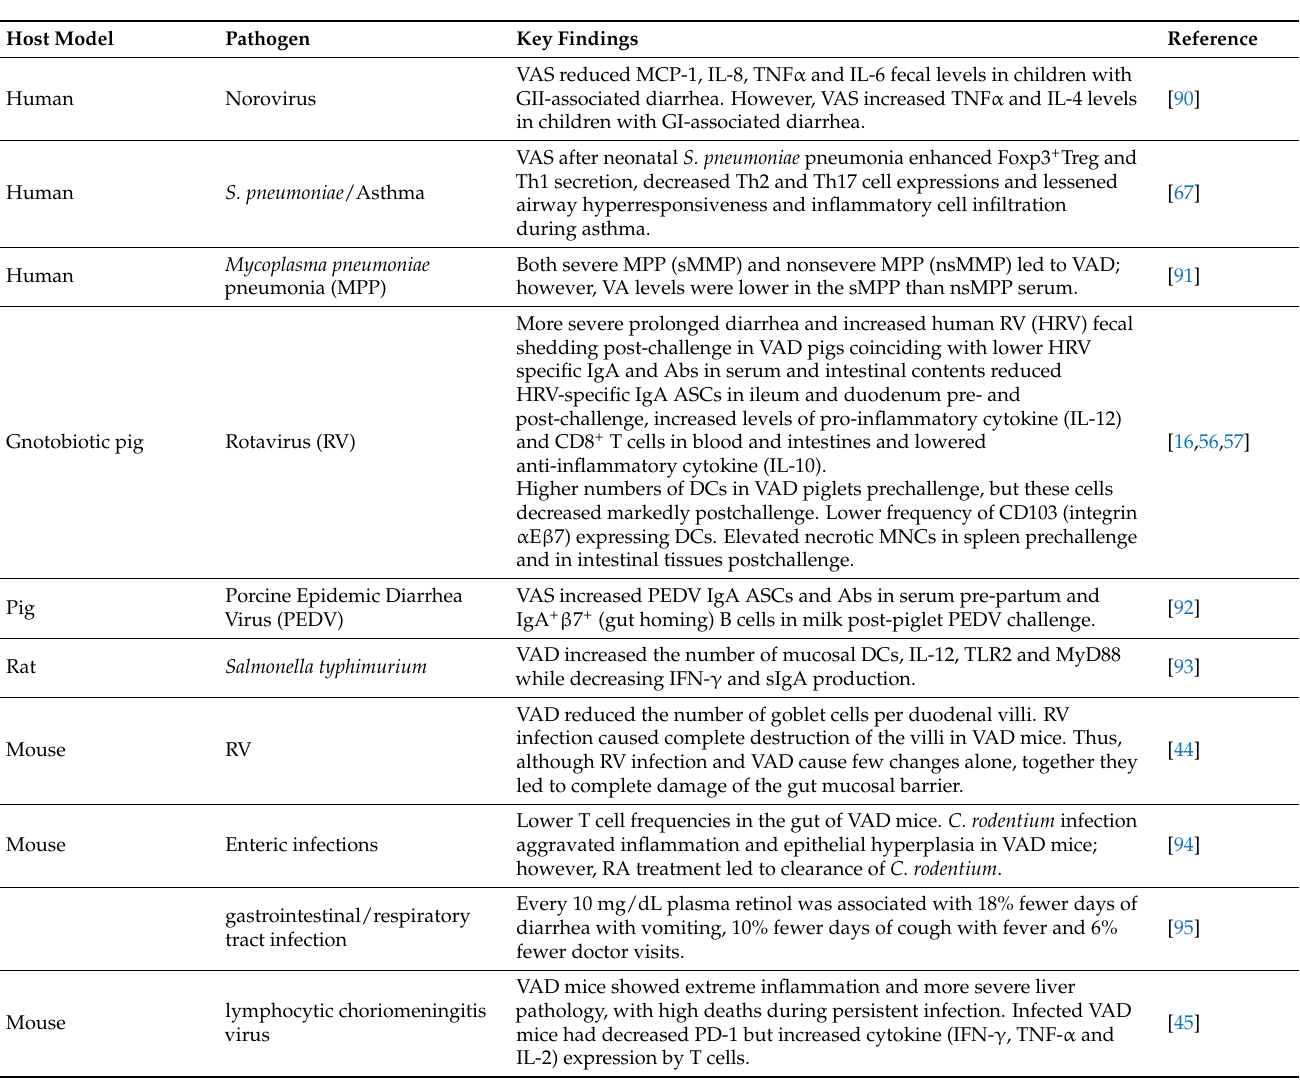
Table 1. Effects of VAD on immune responses to infectious diseases observed in individual clinical studies and animal model